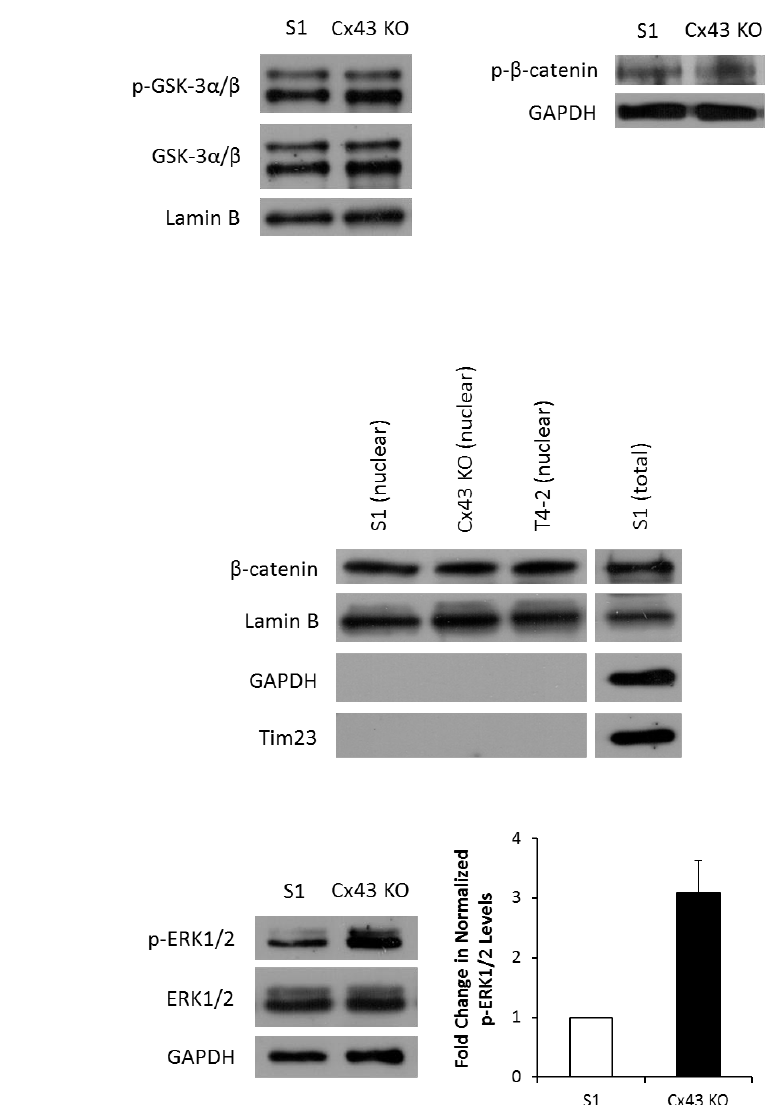
Figure 5. Silencing Cx43 activates MAPK but not Wnt/ β -catenin signaling in S1 cells under 3-D culture conditions. S1 and Cx43-shRNA S1 cells (Cx43 KO) were cultured under 2-D ( A ) or 3-D conditions ( A – D ). ( A , B , D ) Total proteins were extracted on days 4, 9, and 11 in 2-D ( A ; left panel) and on day 11 in 3-D ( A ; right panel, B , D ). Expression of β -catenin, p- β -catenin, GSK-3 α / β , p-GSK-3 α / β , ERK1/2, and p-ERK1/2 was assessed by Western blotting. Lamin B and GAPDH served as loading controls. Three independent experiments were performed. The values depicted in the histogram ( D ; right panel) are the means of fold change in p-ERK1/2 levels in 3-D normalized to that of GAPDH from three independent experiments. Fold change in normalized levels is set to 1 in S1 cells. ( C ) Nuclear proteins were extracted on day 11 (S1 and Cx43 KO cells) or on day 7 in 3-D (T4-2 cells). β -catenin levels were assessed by Western blotting. Lamin B served as loading control. Purity of nuclear fractions was determined by analyzing cytosolic (GAPDH) and membrane markers (Tim23). Total proteins extracted on day 11 in 3-D (S1 cells) were co-analyzed as a control for the detection of GAPDH and Tim23. Three independent experiments were performed.